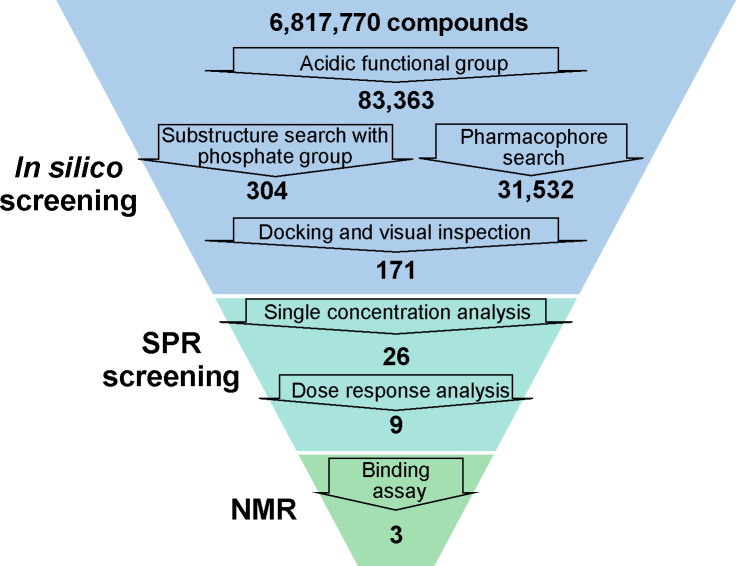
Workflow of screening.NMR, nuclear magnetic resonance; SPR, surface plasmon resonance.